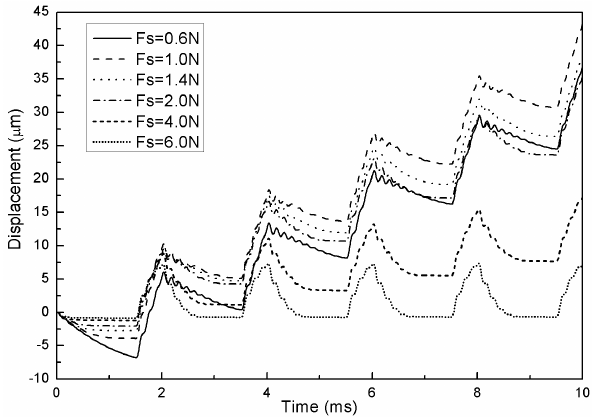
Figure 12. The velocity of the actuator versus the frequency of the input